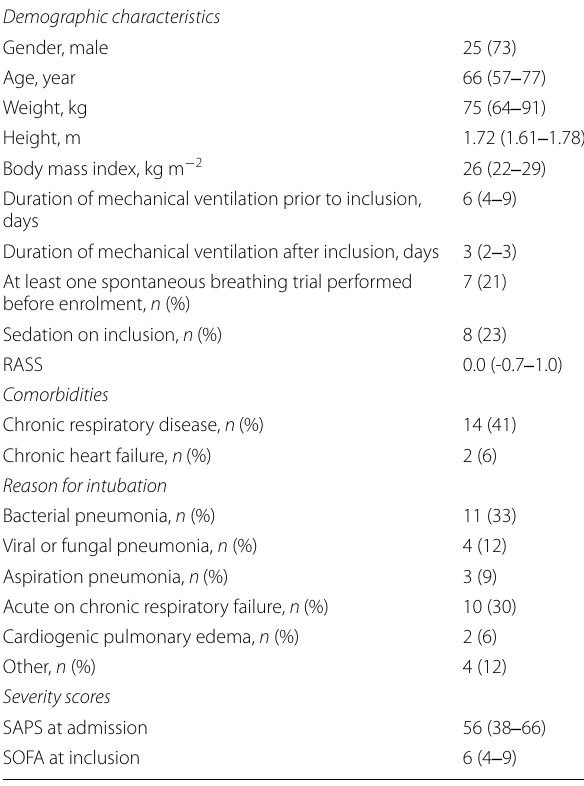
Table 1 Characteristics of the study